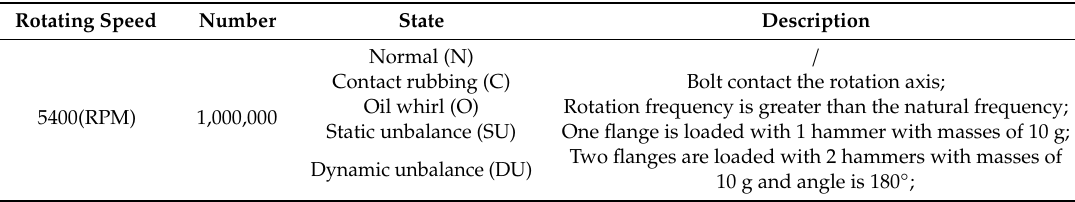
Table 1. Introduction of faults in sliding bear.